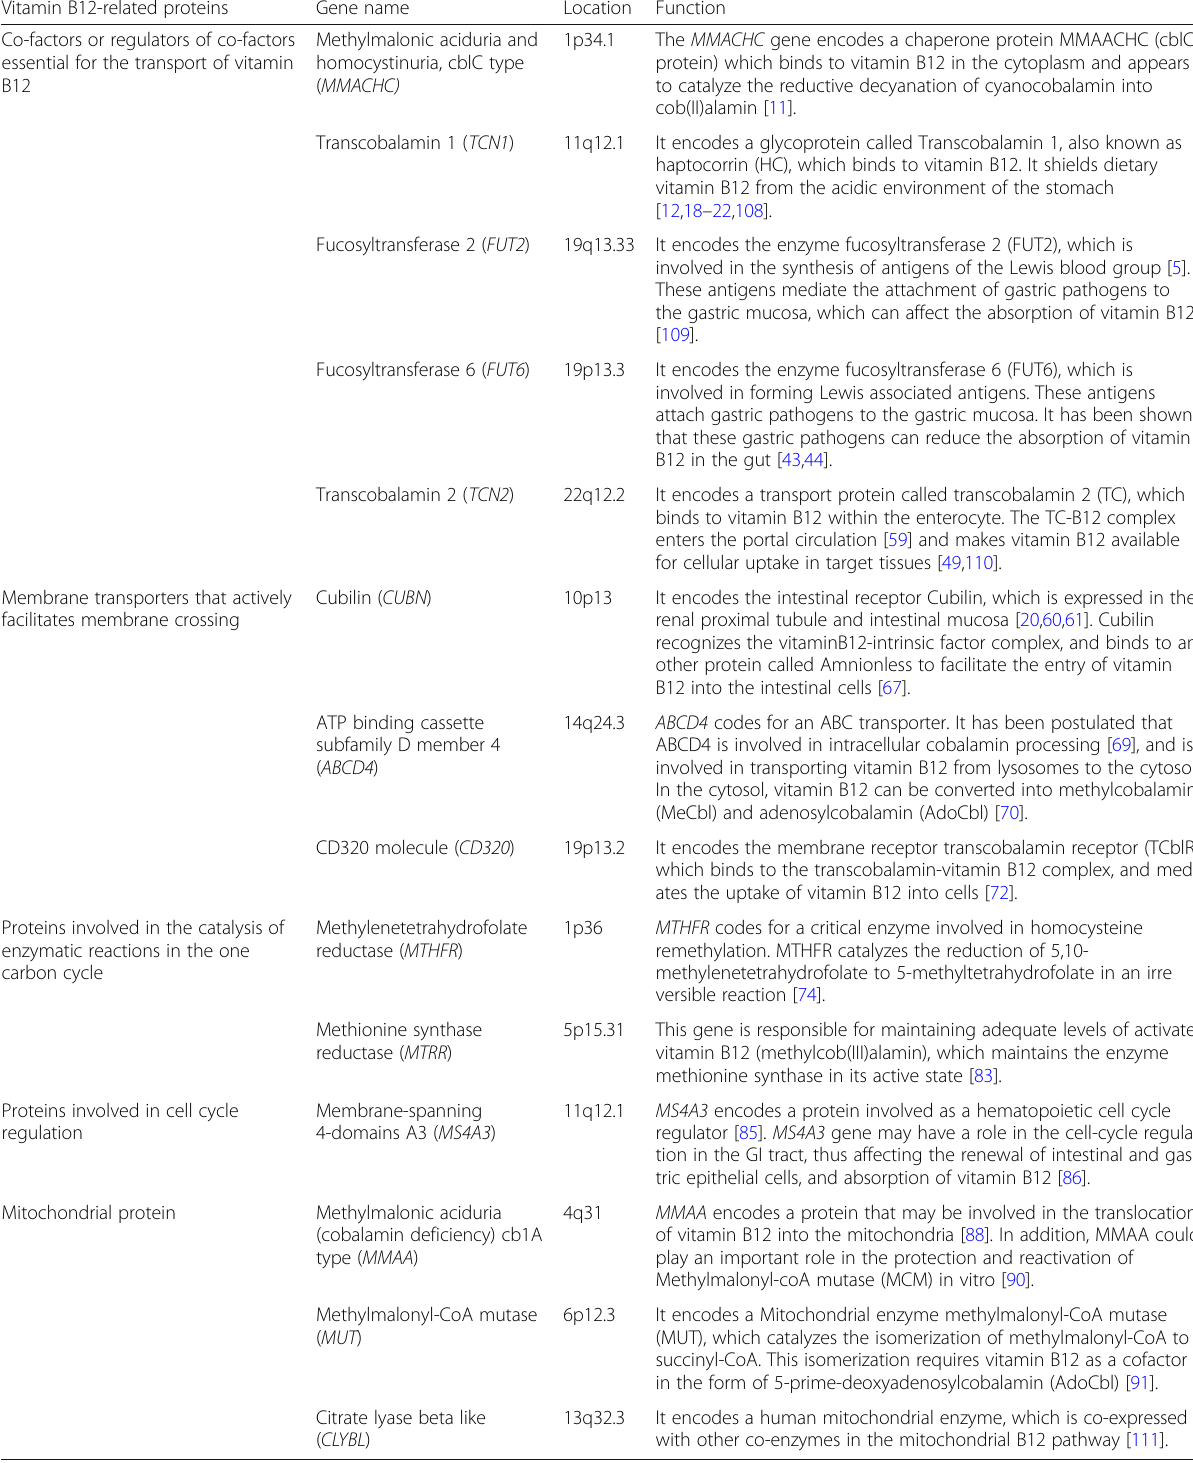
Table 3 A summary of the most frequently studied genes associated with vitamin B12 concentrations. The gene name, gene location and function of the most frequently studied genes associated with vitamin B12 concentrations are summarized in this table Vitamin B12-related